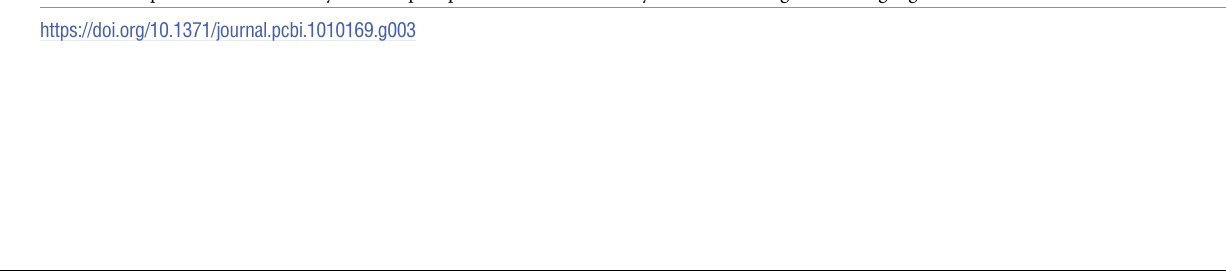
PLOS Computational Biology | https://doi.org/10.1371/journal.pcbi.1010169 January20,